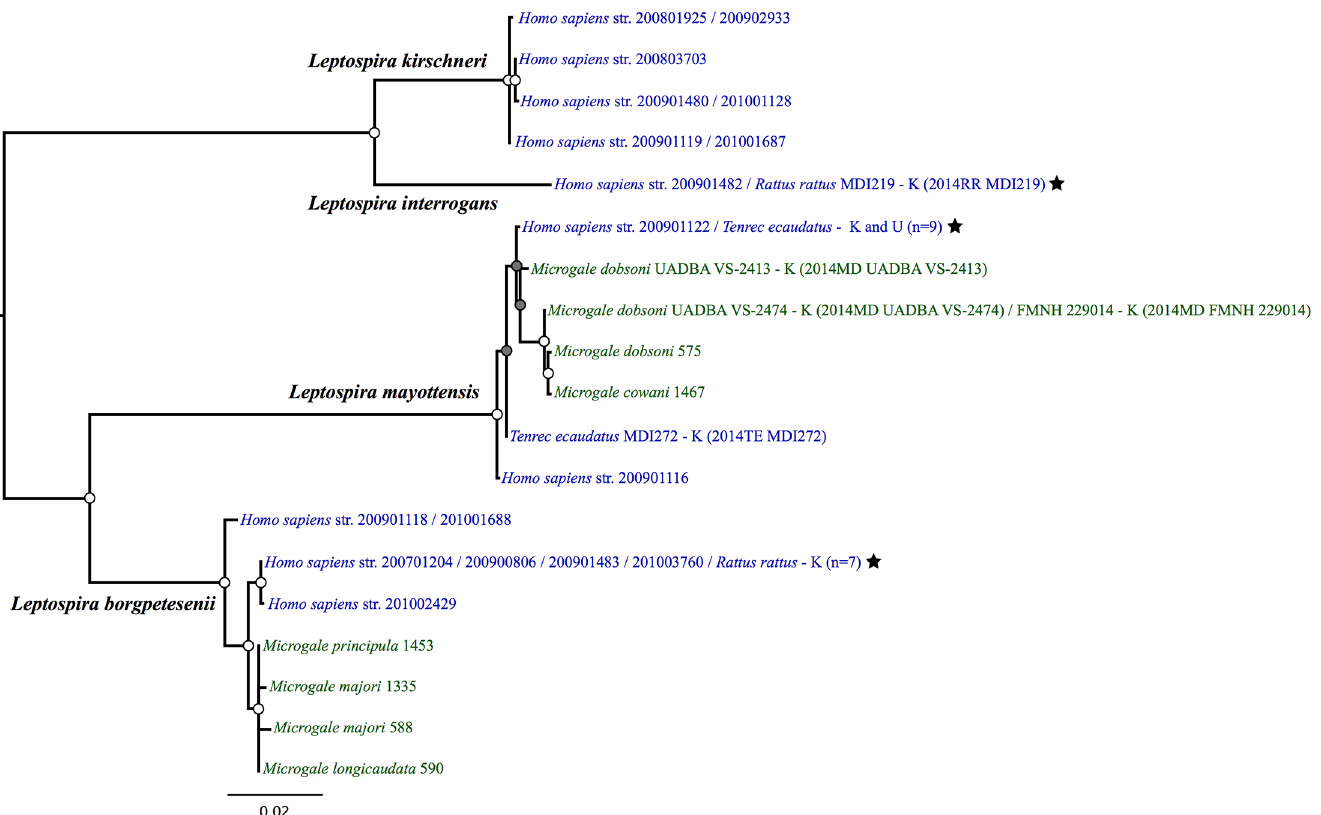
Fig 1. Bayesian phylogenetic tree of pathogenic Leptospira species from Mayotte (blue) and Madagascar (green) based on concatenated sequences of five genes ( secY , adk , lipL32 , lipL41 and rrs2 , total size: 2215 bp). The analysis was realized under the GTR+G substitution model. At the nodes, grey and white circles indicate posterior probabilities superior to 0.70 and 0.90, respectively. Strain numbers of cultures produced herein are indicated in parentheses, “ K ” and “ U ” designating the sequences obtained from kidney or urine, respectively. Stars indicate lineages common to humans and animals ( Rattus rattus or Tenrec ecaudatus ). For Homo sapiens str. 200901122, the same sequence type was found in nine cultures from T . ecaudatus (2014TE MDI222, 2014TE MDI224, 2014TE MDI294U, 2014TE MDI295, 2014TE MDI295U, 2014TE MDI306, 2014TE MD308,